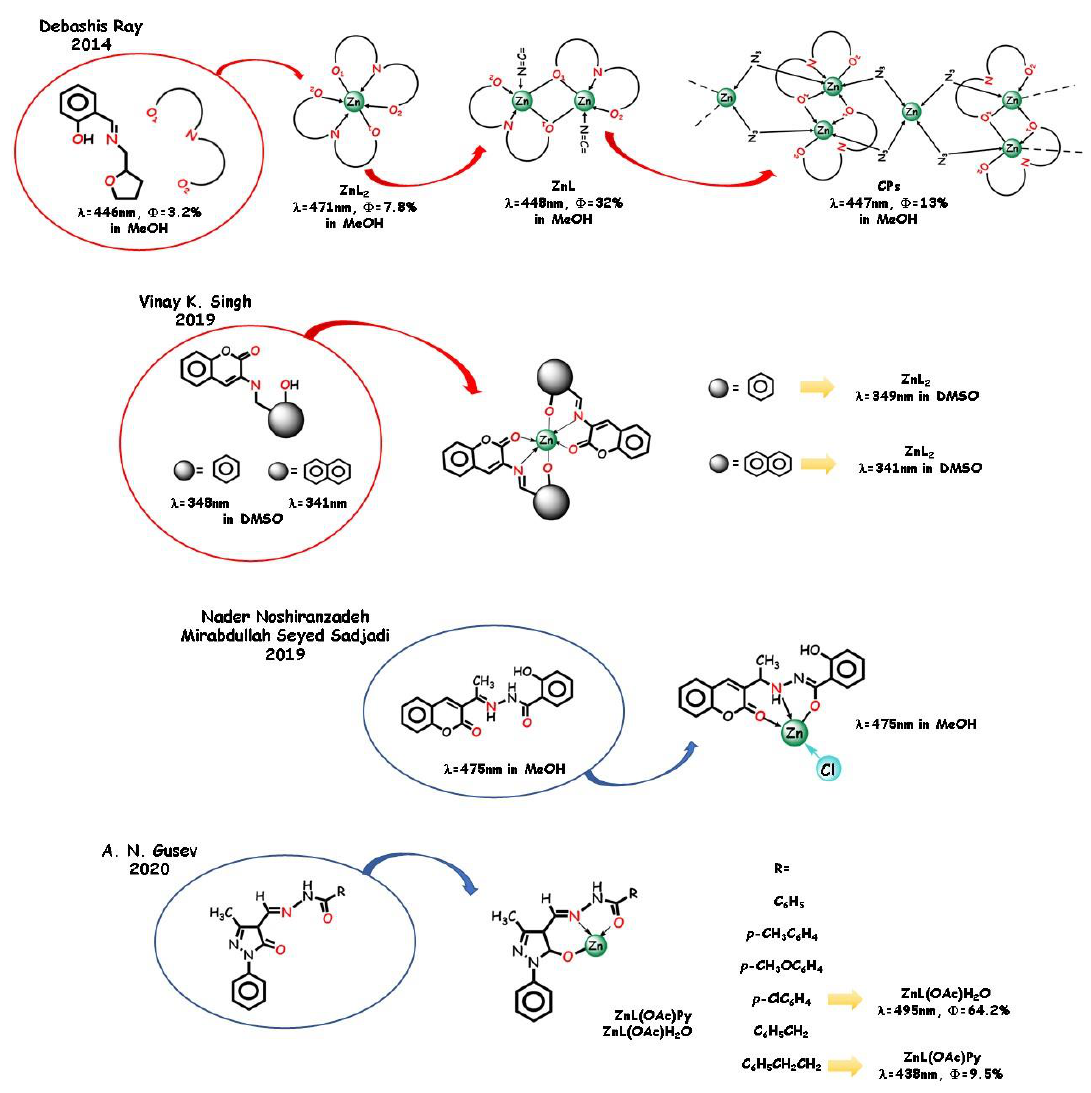
Figure 8. Selected examples of O , N , O ligands and zinc complexes containing the C=N moiety.